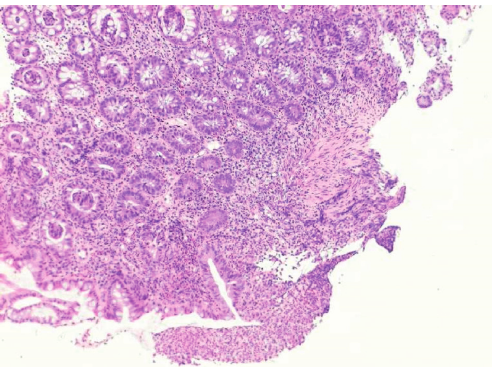
Figure 4: Histology showed no granulomas but patchy inflammation reaching the submucosal layer (10x